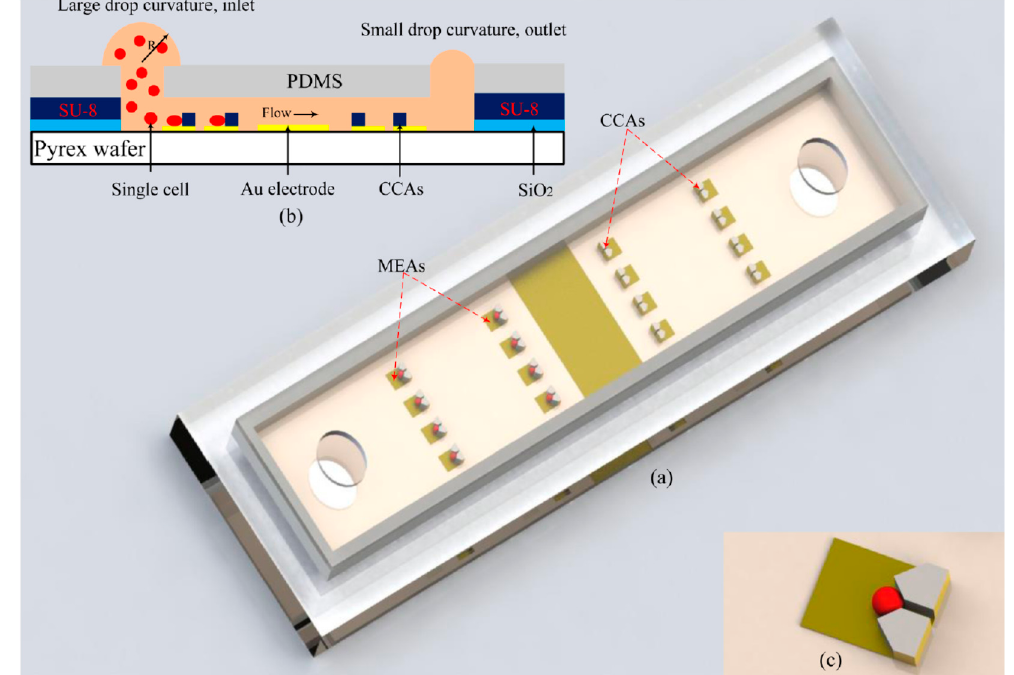
Figure 11. ( a ) 3D image of the sensor chip, which consists of three main parts: microelectrode arrays (MEAs), cell capture arrays (CCAs), and a microfluidic channel with an inlet and an outlet. ( b ) Cross-sectional view of the MFC with a mechanism of passive pumping. ( c ) A V-shaped structure for single cell trapping. Reprinted from Nguyen et al. [54] with permission from American Chemical Society.